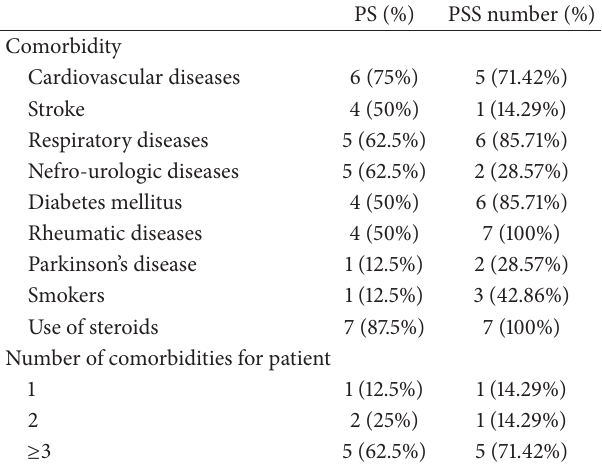
Table 2: Patients’